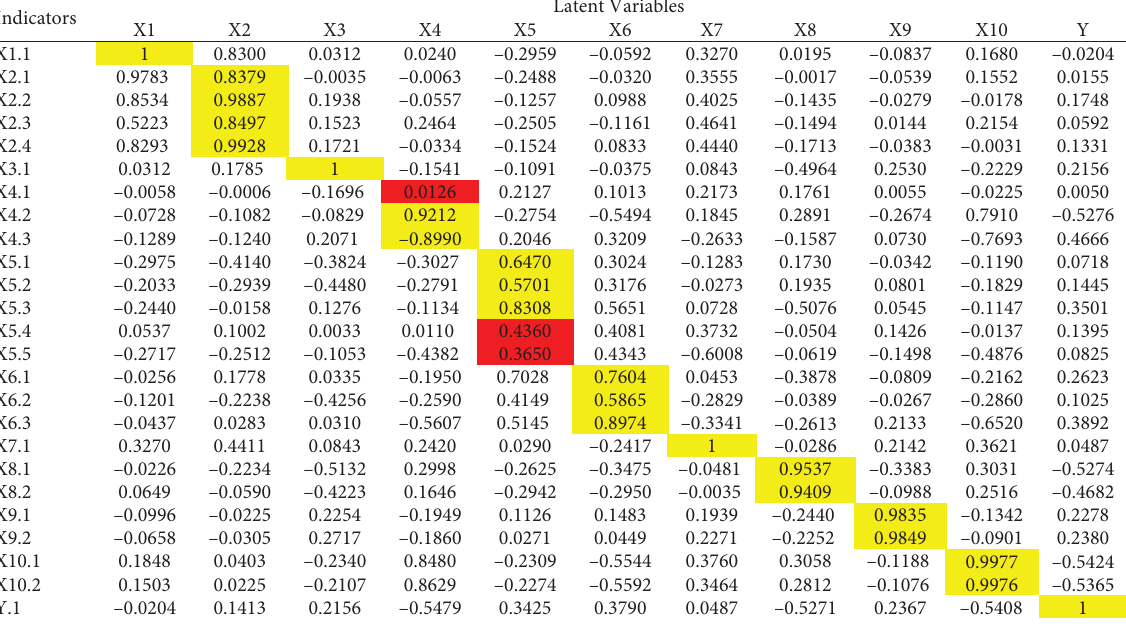
Table 5: Cross-loading of latent variables to indicators.